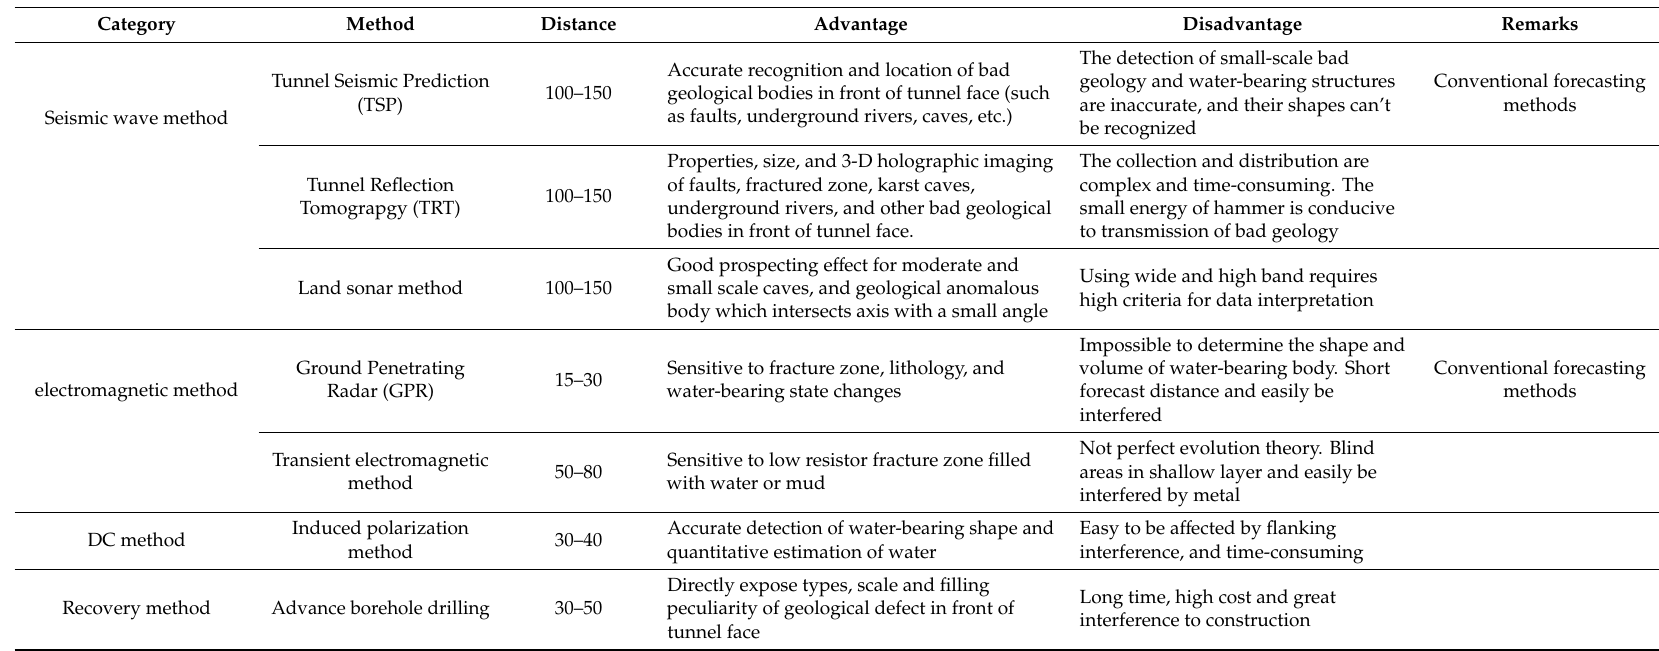
Table 5. Common advanced geological forecast methods and